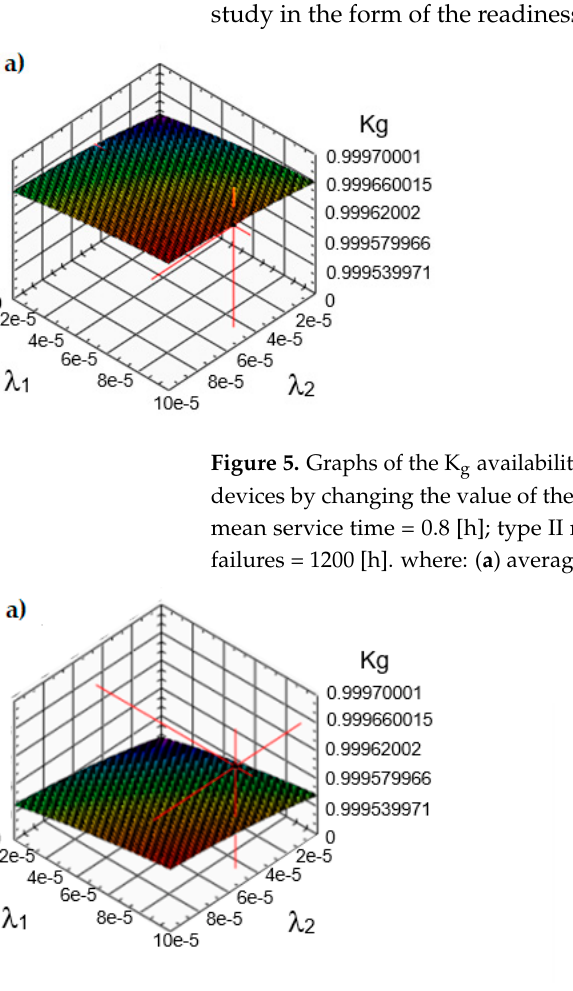
Figure 4. Graphs of the K g availability coefficient in the process of testing the reliability of wind farm devices by changing the value of the average repair time for constant parameters, including: type I mean service time = 0.8 [h]; type II mean operating time = 1.3 [h]; mean time between successive failures = 1200 [h], where: ( a ) mean repair time 0.3 [h]; ( b ) average repair time 0.4 [h].